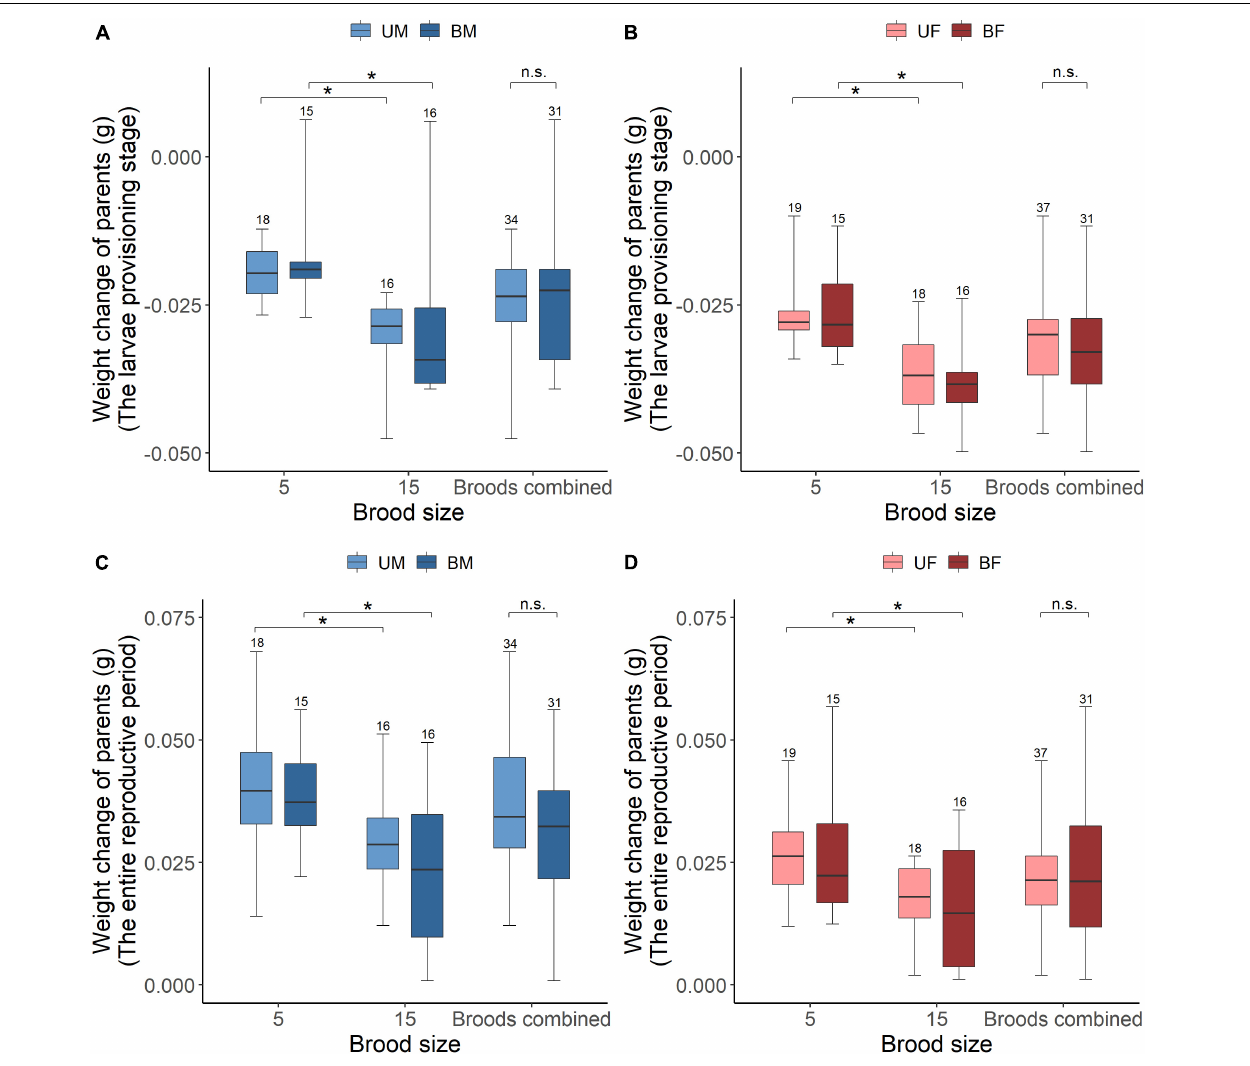
FIGURE 2 | The effect of parental care system (uniparental male, uniparental female, biparental male, and biparental female) and brood size (5 vs. 15 larvae) on weight change of burying beetle during the larvae provisioning stage [values below 0 indicate weight loss; (A) male, (B) female] and the entire reproductive period [values above 0 indicate weight gain; (C) male (D) female] in the first breeding. Boxplots show median, interquartile range, and minimum/maximum range. Numbers above error bars are sample sizes. For statistical analyses see Tables 2 , 3 . Asterisks, significant ( P < 0.05); n.s., not significant; UM, uniparental male; UF, uniparental female; BM, biparental male; BF, biparental